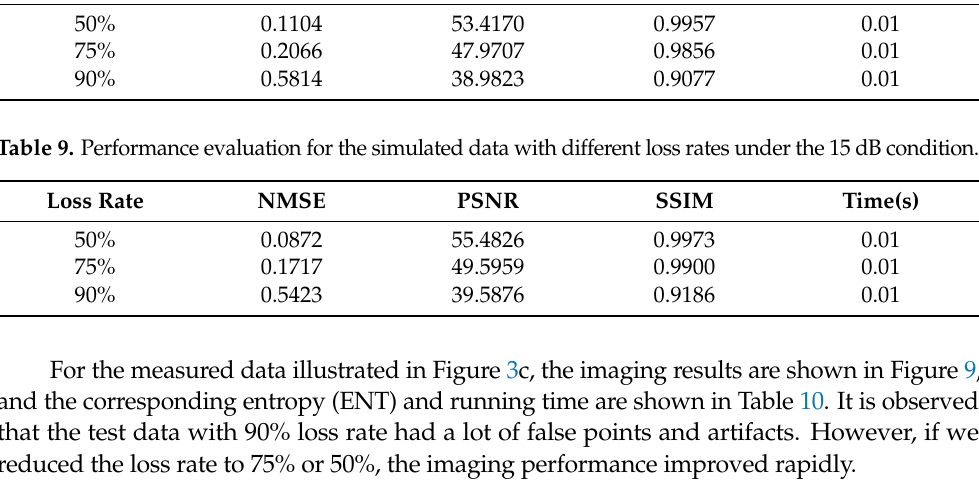
Table 8. Performance evaluation for the simulated data with different loss rates under the 10 dB condition.